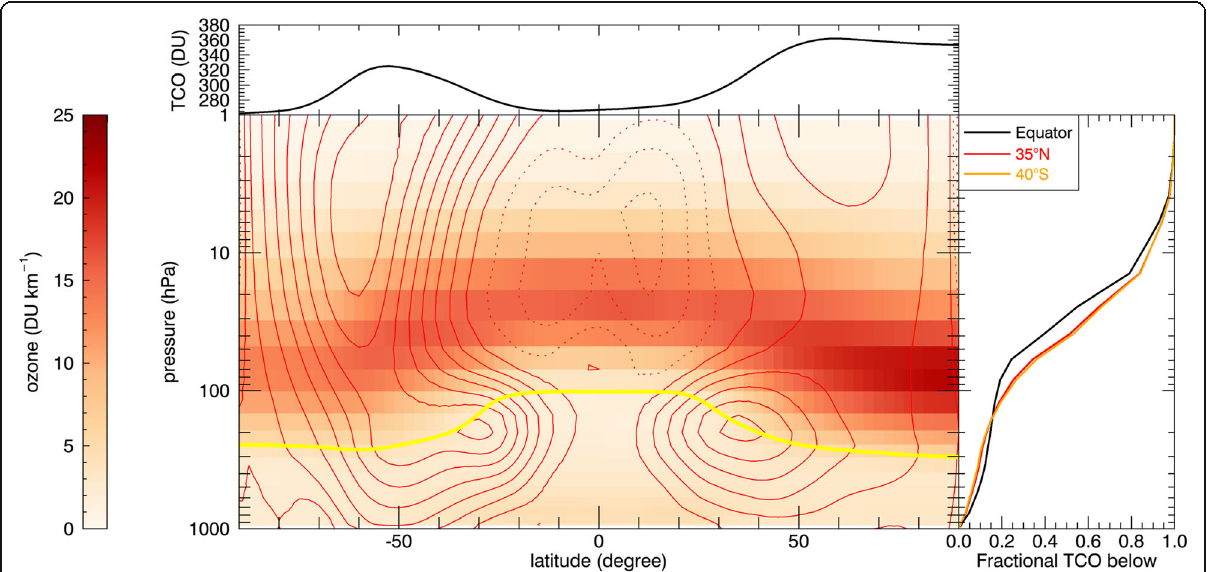
Fig. 6 Climatological ozone distribution (1979 – 2010) from the ERA-Interim reanalysis, along with the tropopause (yellow line). The right panel shows the fraction of the total column ozone below the given height at three different